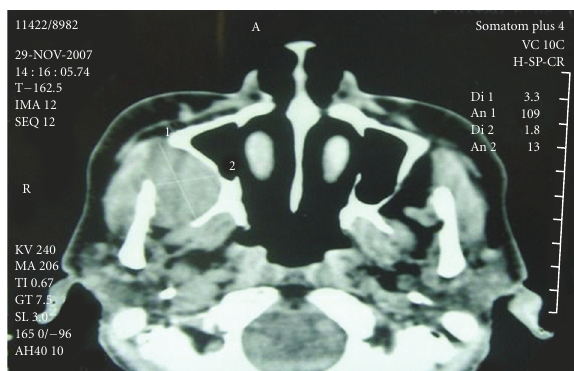
Figure 1: CT scan showing a well limited solid tumor developing from the right infratemporal space indenting upon the posterolat- eral wall of the right maxillary sinus.